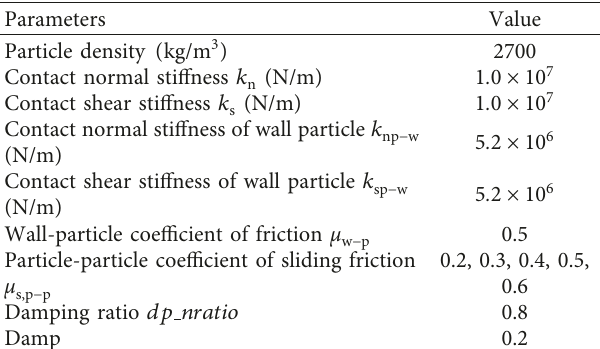
Figure 12 that sphere-shaped particles, i.e., 1-ball particles, are more likely to roll down the pile until the friction be- tween particles and the base plane dissipated all the abun- dant energy stored in the system, and this hinders their forward movement. By contrast, the number of particles rolling down the piles decreases in the granular assemblies of the other four types of models, i.e., the 2-ball with overlap model, the real ballast model, the 4-ball model, and the 2-ball without overlap model, which demonstrates that more particles would keep stable on the surface of piles, resulting in larger slope angles than that of spherical particles. The